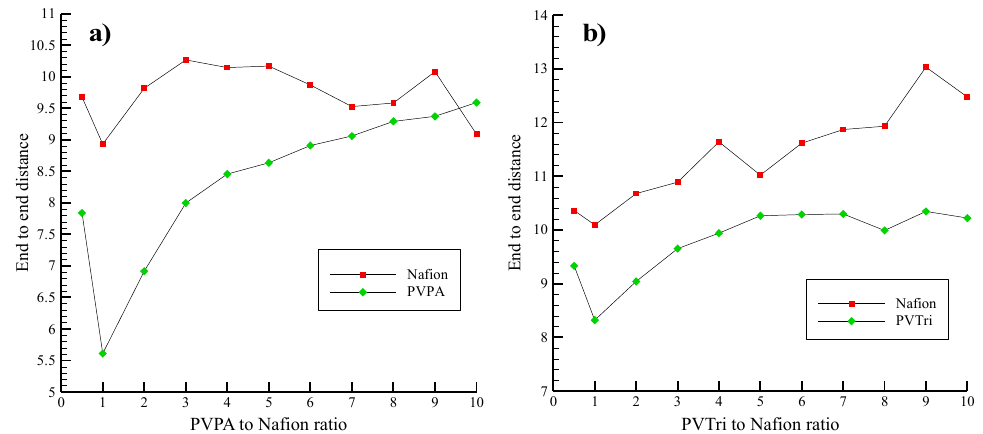
Figure 4. Average RMS end-to-end distances of polymer chains in ( a ) Nafion–PVPA and ( b ) Nafion– PVTri blends at different compositions.